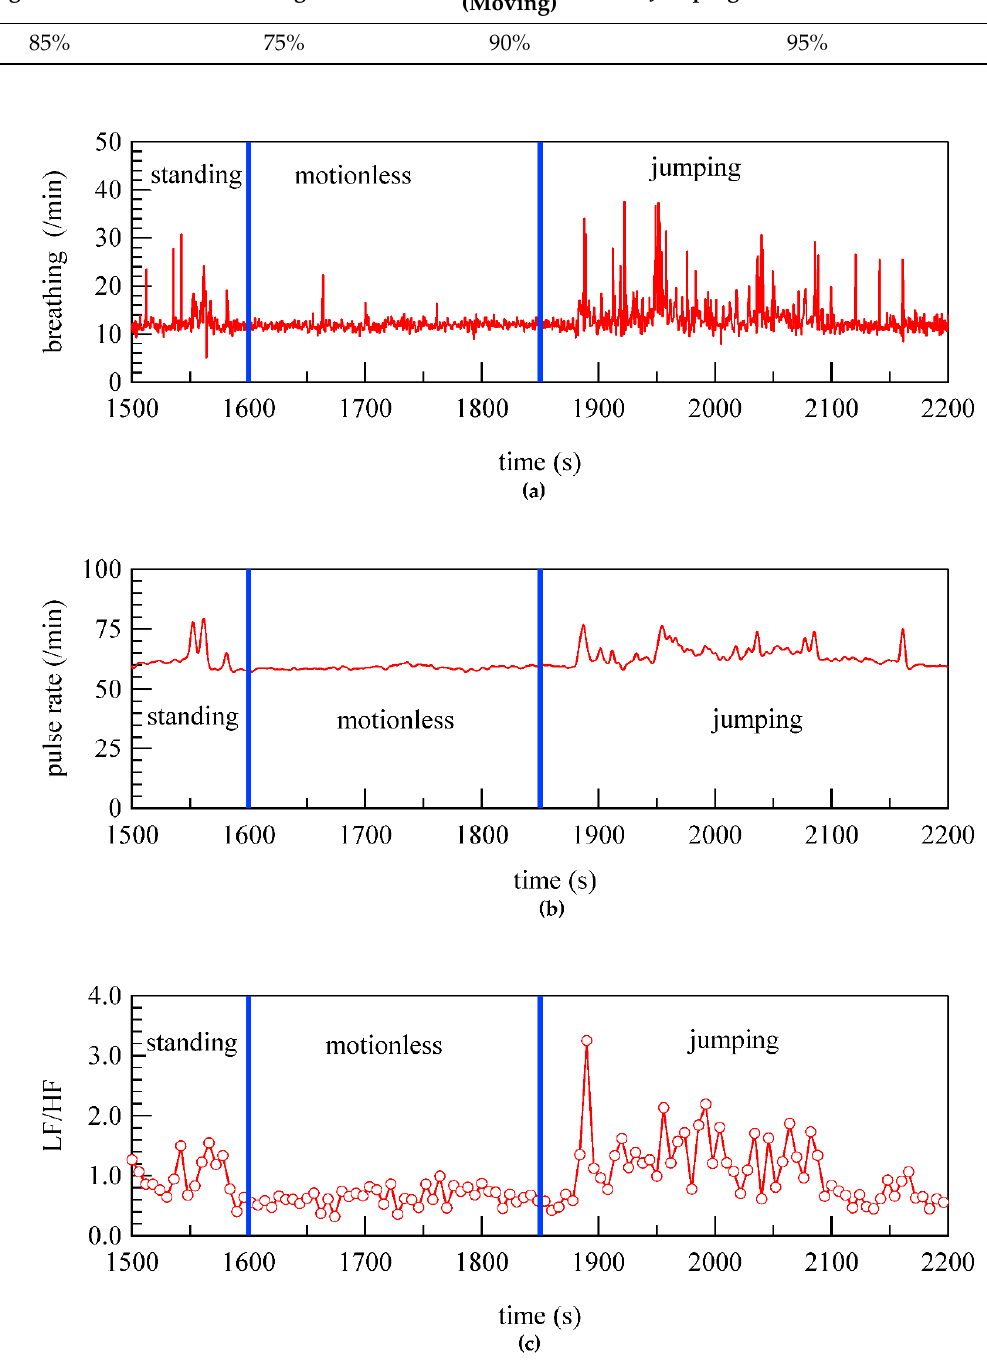
Figure 19. Examples of vital signs obtained from piezoelectric PLLA braided cord: ( a ) respiratory rate ( b ) pulse rate ( c ) LF/HF.